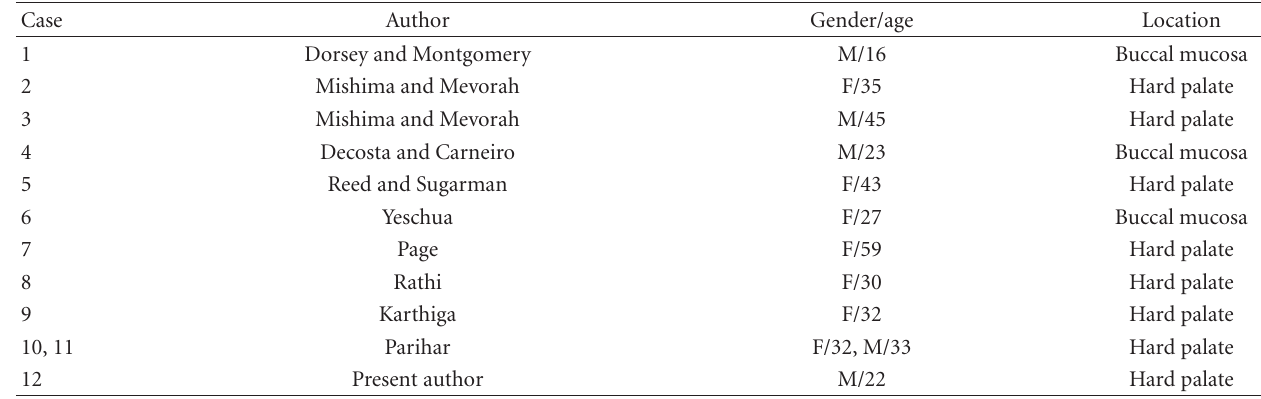
Table 2: Chronological listing of intraoral nevus of Ota (Documented